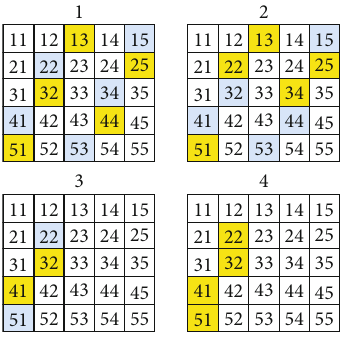
Figure 18: Fifth shading pattern (after applying static recon fi guration). Table 2: Di ff erent connections for power